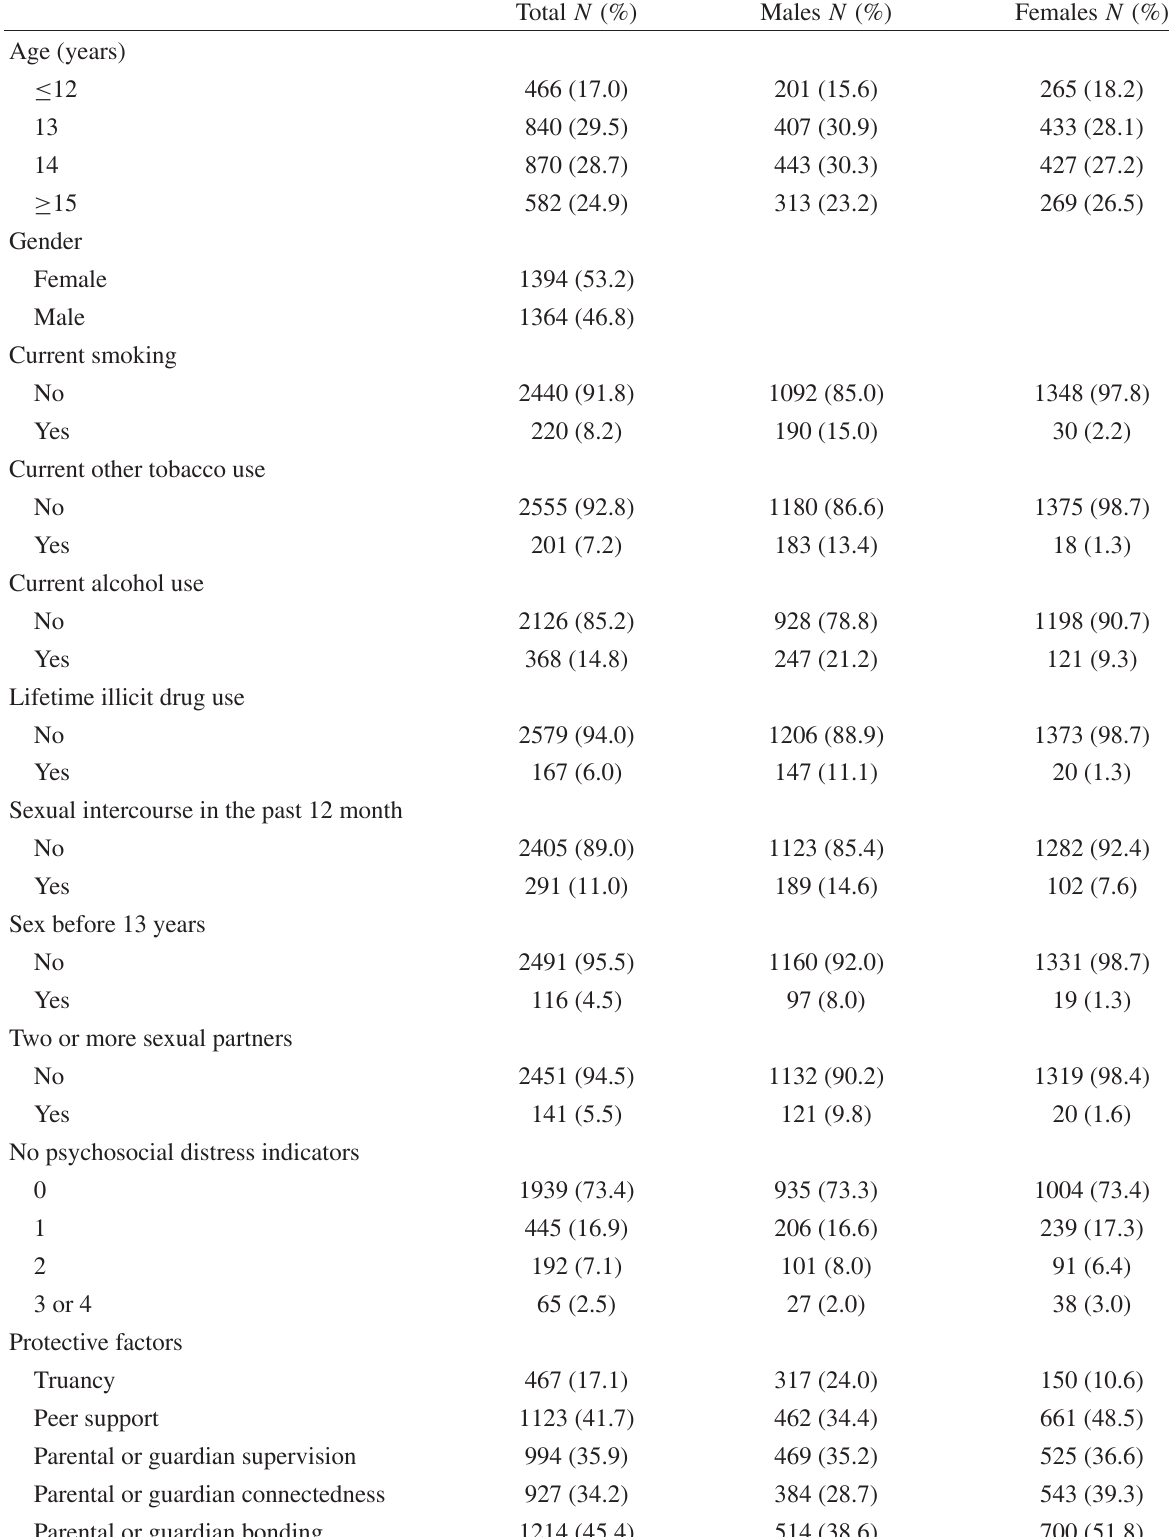
TABLE 1: Sample characteristics among adolescents in Thailand, 2008, N = 2758